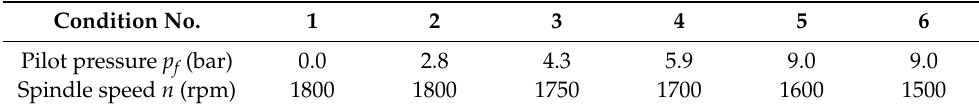
Table 5. Parameters of working